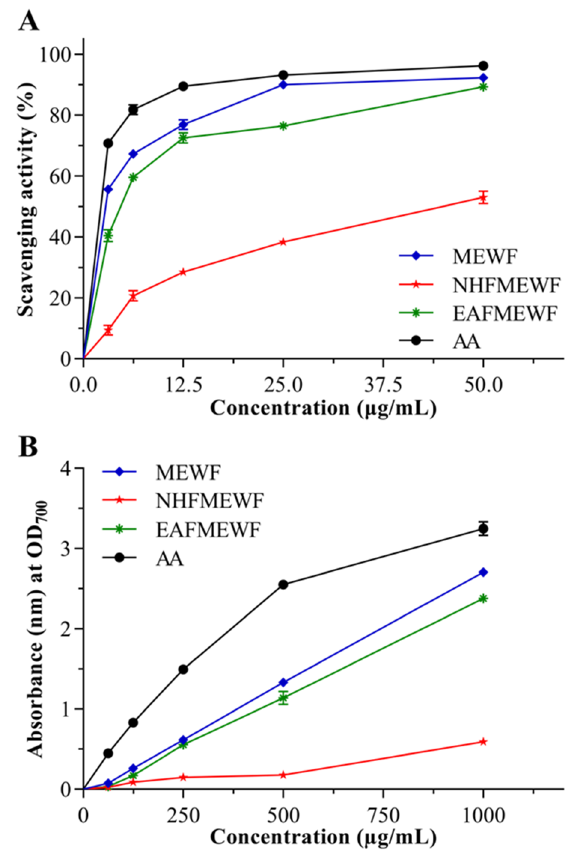
Figure 2. ( A ) Percentage of DPPH free radical scavenging activity, and ( B ) ferric reducing antioxidant power of methanol extract of the W. fruticosa leaves and its derived different fractions at five different concentrations ( µ g/mL) compared to reference antioxidant (ascorbic acid). Values are figured as mean ± SEM ( n = 3). MEWF, methanol extract of W. fruticosa leaves; NHFMEWF, n-hexane fraction of methanol extract of W. fruticosa leaves; EAFMEWF, ethyl acetate fraction of methanol extract of W. fruticosa leaves; AA, ascorbic acid.